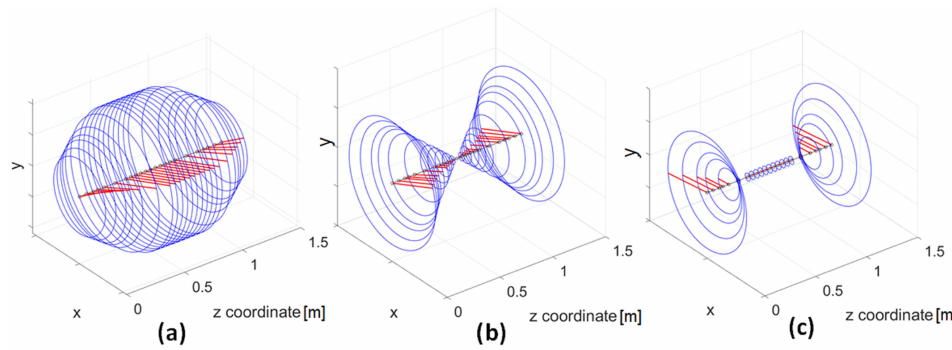
Figure 10. First 3 forward whirl mode shapes at ( a ) 2700 RPM, ( b ) 5300 RPM and ( c ) 9300 RPM.